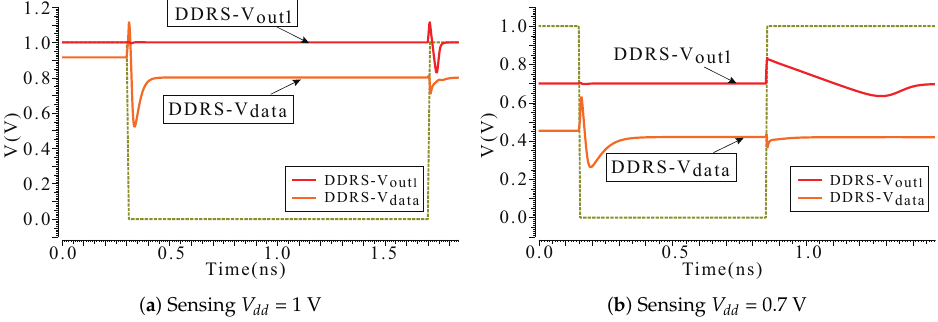
Figure 4. Sensing AP as an example, the sensing operation waveform of DDRS (see Figure 1d). As both sensing and amplify phase need to obtain the voltage changes between V data and out1, the DDRS waveform is separately demonstrated with ( a ) sensing V dd = 1 V and ( b ) sensing V dd = 0.7